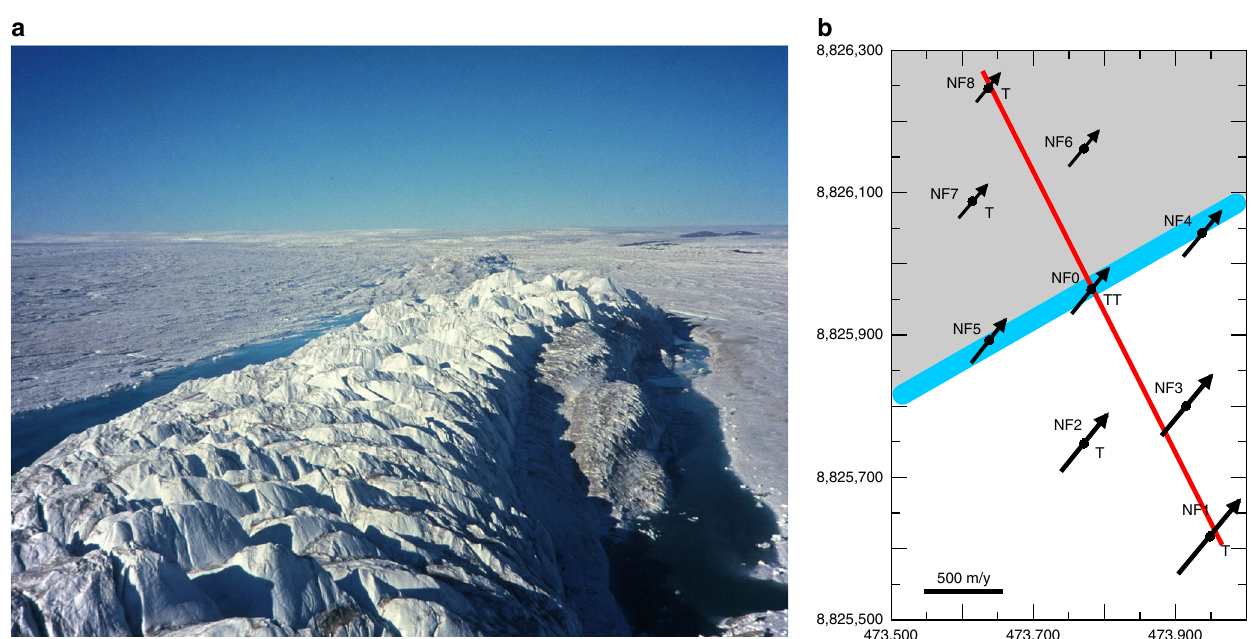
Fig. 2 Migardsormen ice ridge and the local measurements. a Ice ridge of Midgardsormen on the northern part of the ice shelf, close to the location of the ice ridge measurements in the 1990s. The view is upstream towards the grounding line of 79 North Glacier (photo: C. Mayer, 1998). b measurements of the Midgardsormen experiment. The blue line represents the ice ridge, the red line the seismic pro fi le. Ice velocities are displayed as black arrows and the positions of tilt meters (T) are indicated. The grounded part is indicated by gray